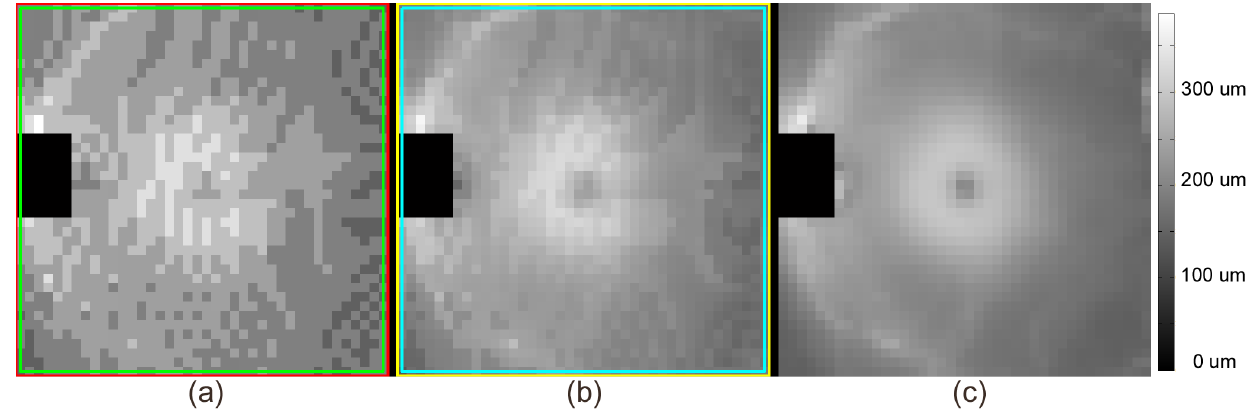
Figure 11. Example of tissue thickness map of the region bounded by two coupled terrain-like surfaces (the layer containing the outer segments of the retinal photoreceptors) segmented by (a) Conventional graph search of ‘‘input volume data’’ delineated by the red and green surfaces in Fig. 10 (b); (b) Non-Euclidean graph search of ‘‘input volume data’’ delineated by the yellow and cyan surfaces in Fig. 10 (b); (c) Mapping from segmentation results of the reference standard volume.